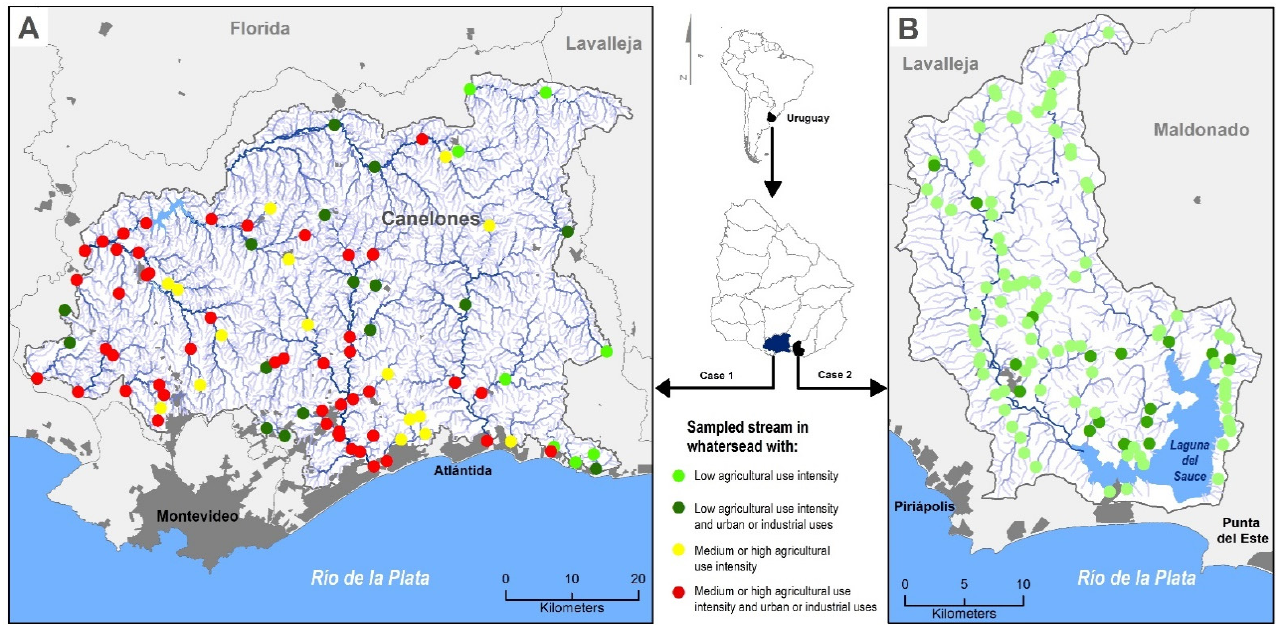
Figure 1. Case study area and data collection points in lotic systems for Case 1 ( A ) and Case 2 ( B ). In both maps dark grey tone corresponds to urban areas and tones from light (1) to dark blue (8) to stream order according to Strahler’s classification system. Agricultural use intensity values were taken from Díaz et al. 2018 [47].